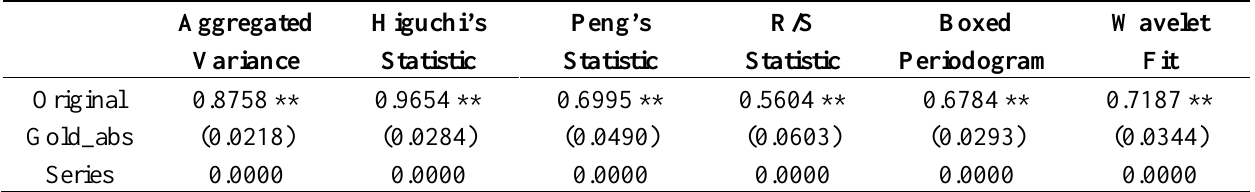
Table 6. Scaling exponent H test results of gold return volatilities (full